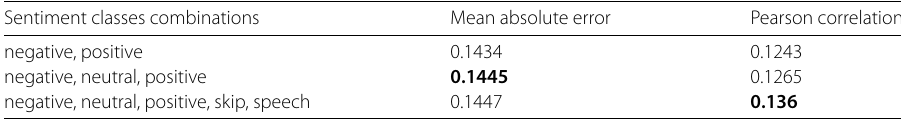
Table 16 Results for linear regression model with sentiment class frequency features. Mean absolute error and Pearson correlation Sentiment classes